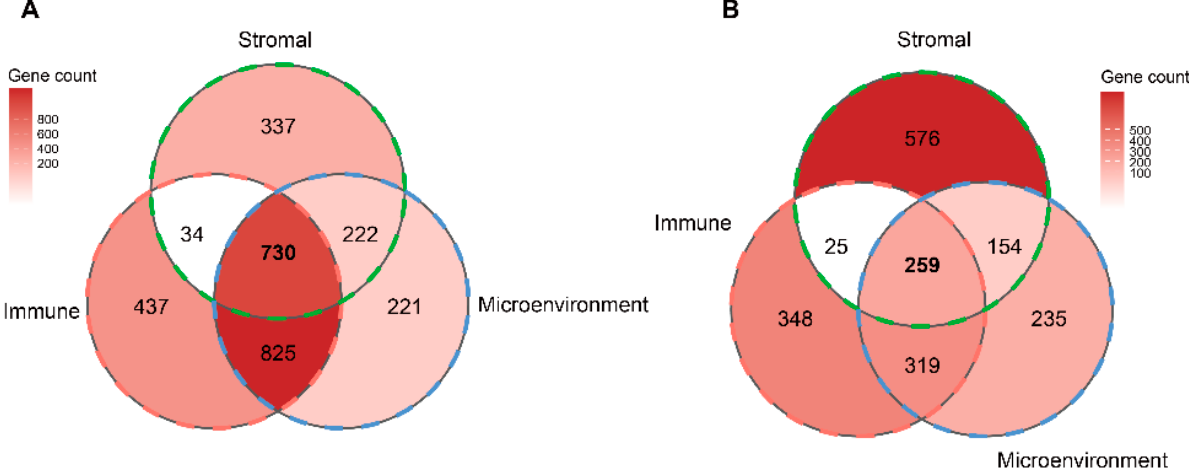
Figure 3. The determination of TME-related genes. ( A ) Venn diagram showing the number of DEGs that were up-regulated in the immune, stromal and, microenvironment groups. ( B ) Venn diagram showing the number of DEGs that were down-regulated in the immune, stromal, and microenvironment groups.